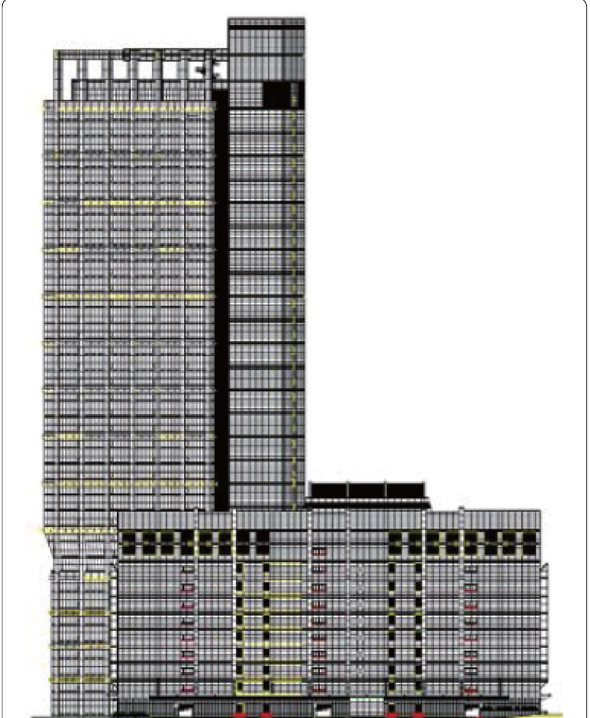
Fig. 9 The 39‑story